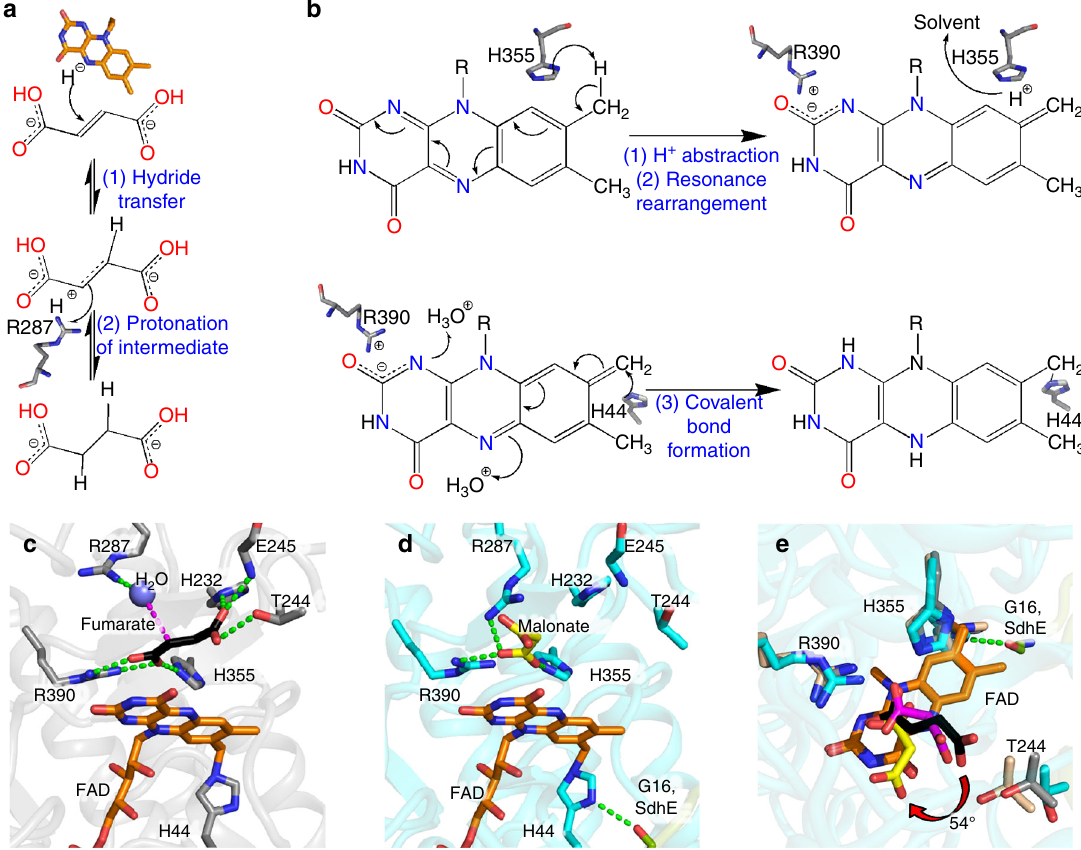
Fig. 3 Mechanism of fumarate reduction and covalent fl avinylation supported by the FrdA active site. a Chemical mechanism of fumarate reduction requires oriented binding of fumarate so that the C2 = C3 double bond is aligned along FAD. The proposed chemical steps involve a transfer of a hydride from the fl avin and a proton from FrdA R28732 . b Probable mechanism of covalent fl avinylation requires a new position for dicarboxylate and three steps. The fi rst two steps (top panel) are proton abstraction from C8 α and resonance rearrangement to delocalize the resultant negative charge between N1 and C2. The third step (bottom reaction) is the attack by a histidyl ligand. c The active site of the fumarate-bound FrdA subunit (PDB entry 3P4P 21 ) from the assembled FrdABCD complex optimizes dicarboxylate orientation along the FAD with hydrogen-bonding interactions to FrdA H232 , FrdA H355 , and FrdA R390 . It is proposed that the transition state is achieved when FrdA T244 of the capping domain hydrogen-bonds to fumarate and twists this molecule, allowing fumarate to accept hydride from the N5 of FAD and a proton from FrdA R287 . d In the FrdA-SdhE assembly intermediate, malonate interacts with and orients the active site side chains of FrdA H355 and FrdA R390 , promoting proton abstraction and resonance stabilization. However, malonate does not interact with FrdA H232 or FrdA T244 , likely preventing catalysis on the dicarboxylate. The imidazole ring of the FrdA H44 histidyl ligand is oriented by a hydrogen-bonding interaction to SdhE G16 , enabling nucleophilic attack. e An overlay of the active sites of fumarate (black) bound to FrdABCD (PDB entry 3P4P 21 , gray), malonate (magenta) bound to avian SdhABCD (PDB entry 2H89 34 , tan) and malonate (yellow) bound to FrdA-SdhE (cyan). The view is rotated by 90° with respect to c , d , highlighting the 54° rotation